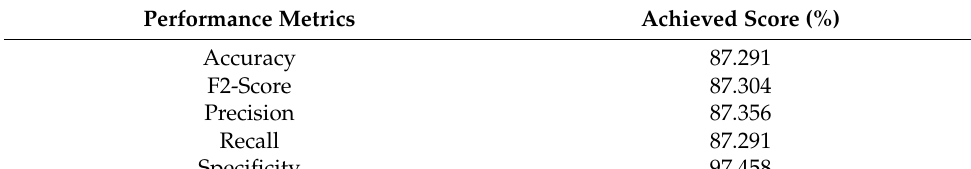
Table 13. Performance metrics of DenseNet201 for six-class classifier.